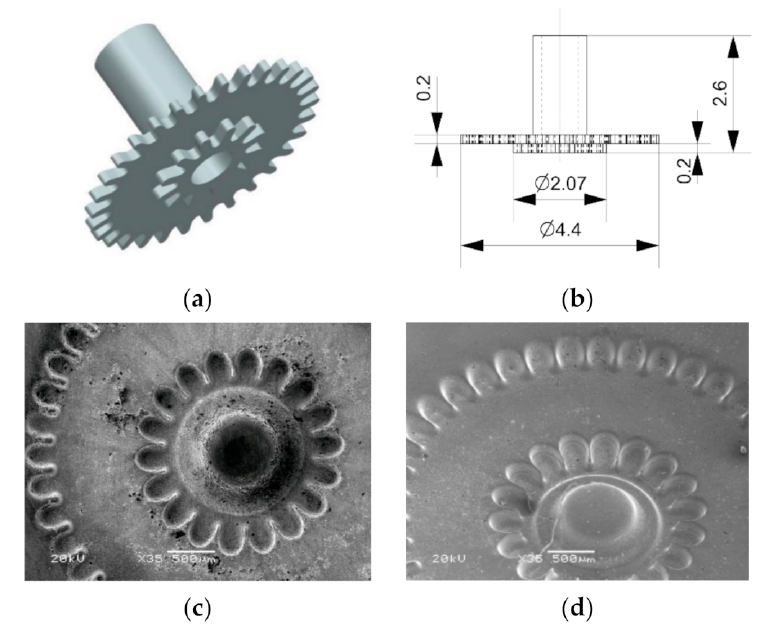
Figure 6. Example of electrochemical sinking application: ( a ) electrode tool 3D model; ( b ) scheme of the electrode tool; inner structure machined in 1.4301: ( c ) steel; ( d ) pure nickel